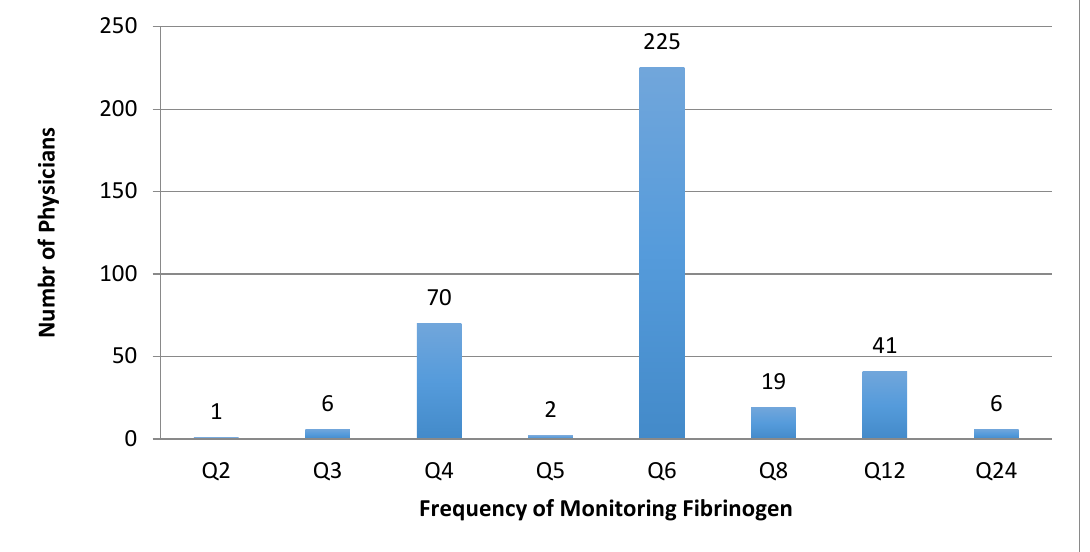
Figure 2. Percentage of practice that is interventional radiology (IR) of the respondents of the survey. Three hundred and seventy-four respondents (82%; n = 81) monitored fibrinogen during thrombolysis, and 18% do not monitor fibrinogen. The most frequent interval for fibrinogen blood draws was every 6 h ( n = 225; 49.5%), ranging from 2 to 24 h (Figure 3).